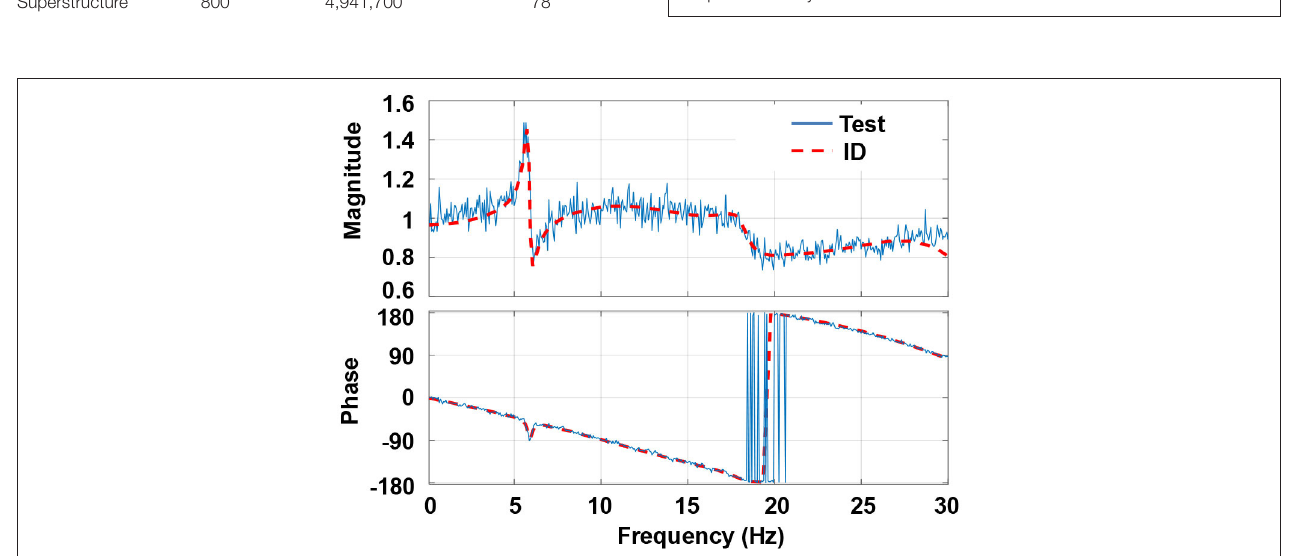
FIGURE 10 | System identification of the shake table with the experimental substructure of the simplified BMD system.